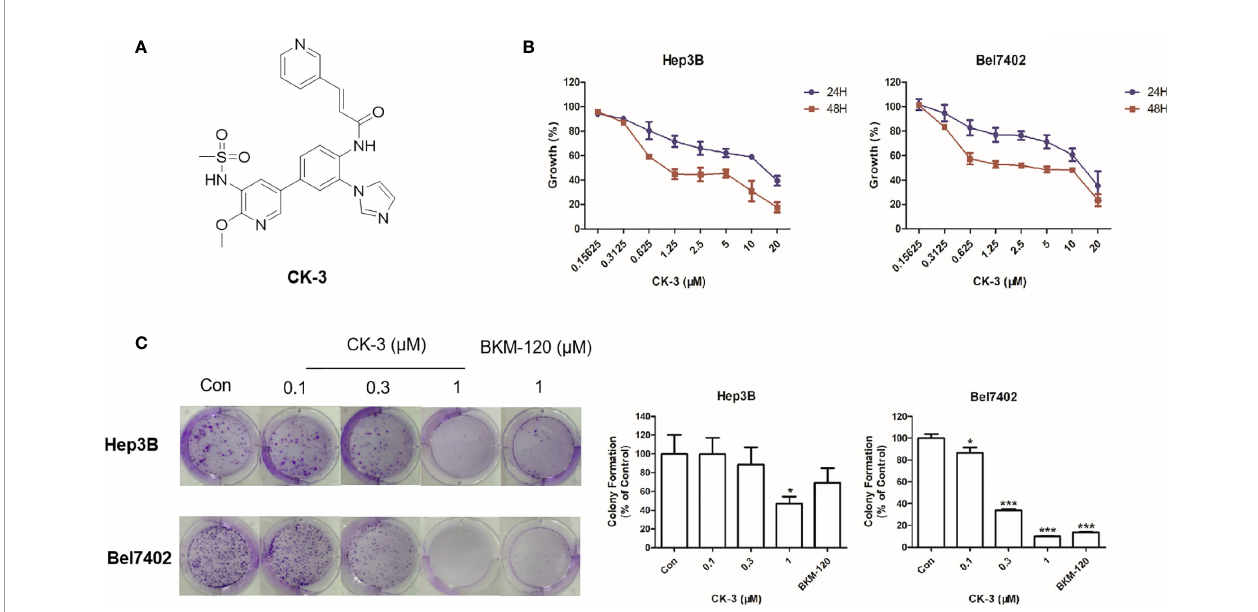
FIGURE 1 | The effect of CK-3 on Hep3B and Bel7402 cell proliferation. (A) Structure of CK-3. (B) MTT assay of cells treated with CK-3 for 24, 48, and 72 h. (C) Effect of CK-3 on cell proliferation as evaluated with the colony formation assay. Data are presented as the mean ± SD of three independent experiments (n = 3). * p < 0.05, *** p < 0.001 compared with the control